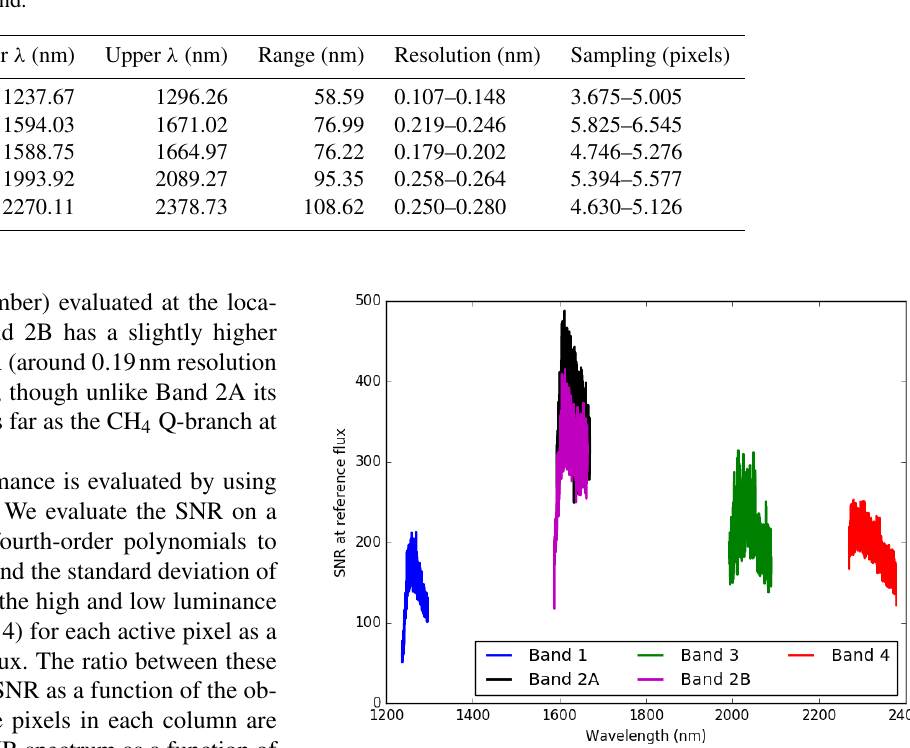
Table 5. Spectral performance of the GHOST spectrometer, as determined from the wavelength calibration measurements described in Sect. 3.3. The ranges of spectral resolution and sampling are obtained from the minimum and maximum fitted full width half maxima of the emission lines measured for each band.